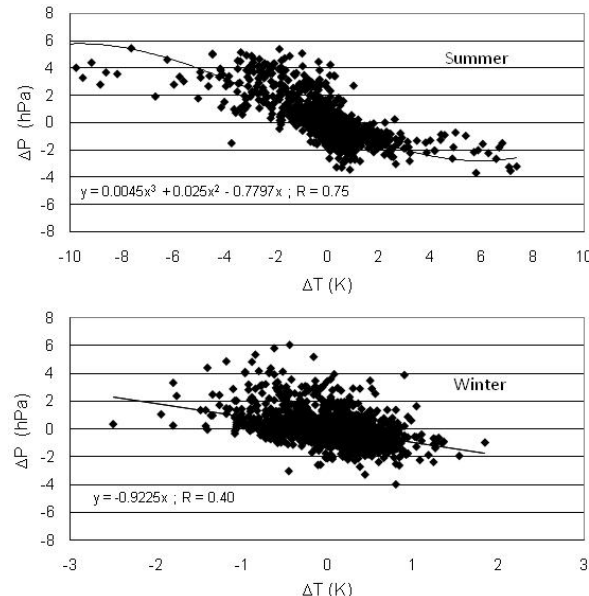
Figure 6. (Top) hourly ∆ P versus ∆ T during summer. (Bottom) hourly ∆ P versus ∆ T during winter. We note that during winter the ∆ P and ∆ T hourly variations appear less correlated than during summer.